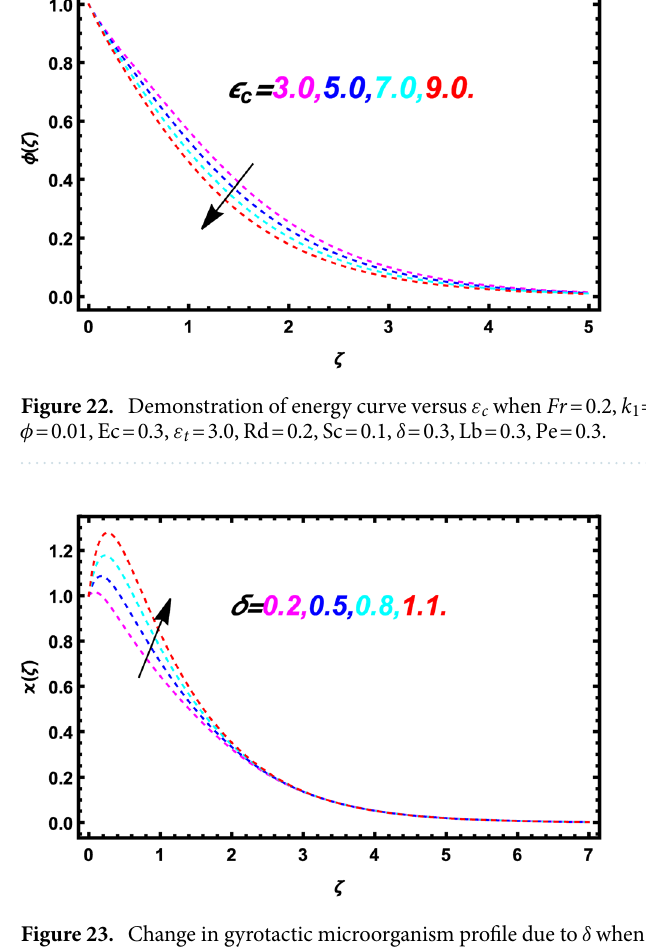
Figure 23. Change in gyrotactic microorganism profile due to δ when Fr = 0.2, k 1 = 0.1, k 2 = 0.3, M = 0.5, m = 0.2, Rd = 0.2, Sc = 0.1, ε Lb = 0.3, Pe = Pr = 5.3, φ = 0.01, Ec = 0.3, ε t = 3.0, C = 3.0,